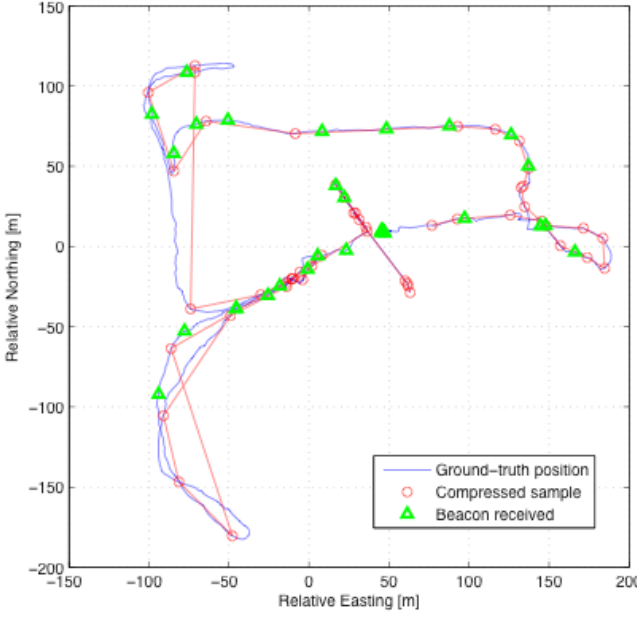
Figure 4 . Compression of trajectory data for an animal moving around a paddock. The beacons in the figure are data transmission